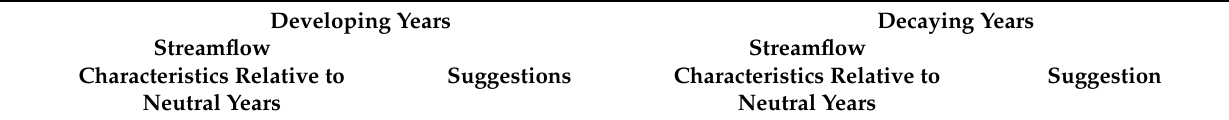
Table 2. Changes in streamflow characteristics and suggestions to water resource managers in each